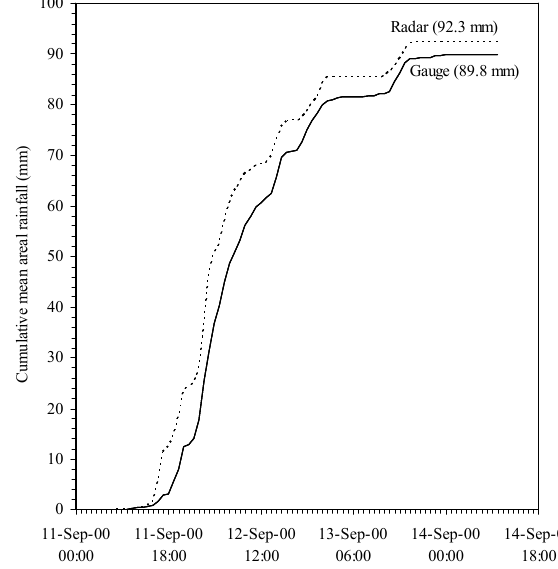
Figure 10. Fig. 10. Cumulative mean areal rainfall estimates based on 13 rain